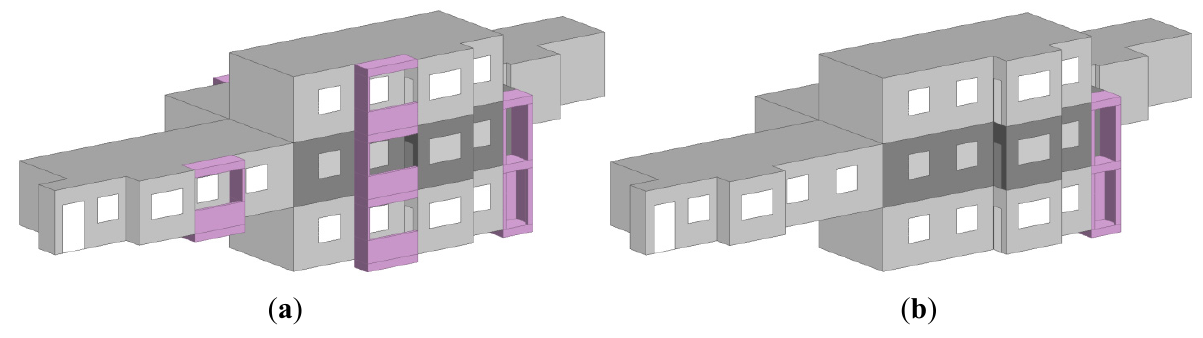
Figure 3. ( a ) M1: Models with and ( b ) M2: without a